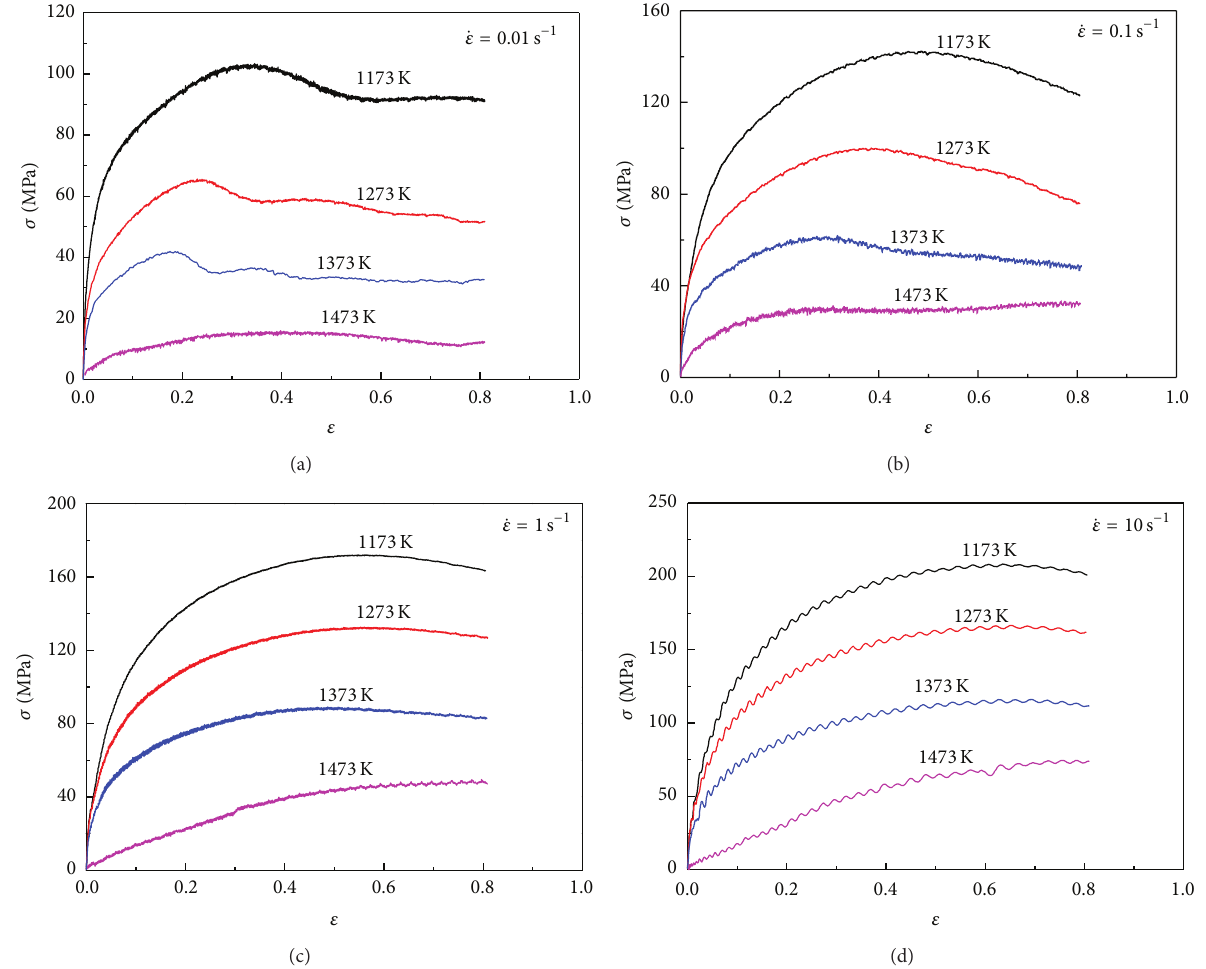
Figure 1: The true stress-strain curves of as-cast 20MnNiMo alloy under the different temperatures with strain rates (a) 0.01 s −1 , (b) 0.1 s −1 , (c) 1s −1 , (d) 10 s −1